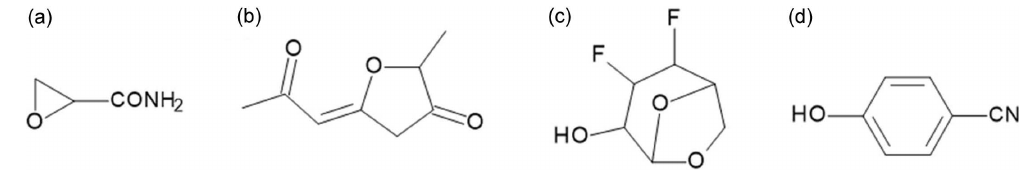
Figure 18 Structures with two molecules per asymmetric unit for which HAR with transferable atoms was applied: ( a ) ARAQUH, ( b ) SIFBAN, ( c ) EGUFIY, ( d ) PCYPOL04.